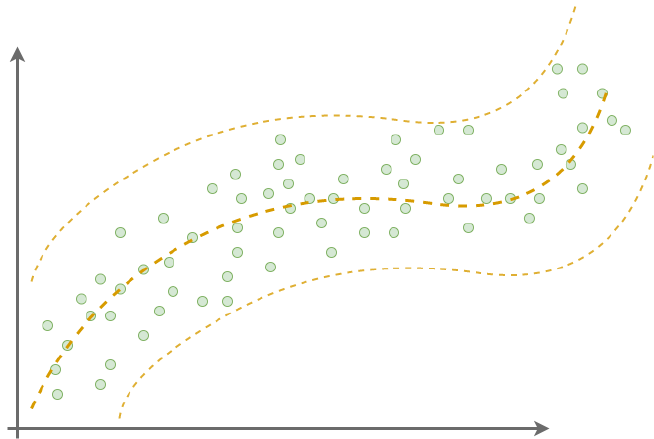
Figure 10. Representation of a nonlinear regression model.